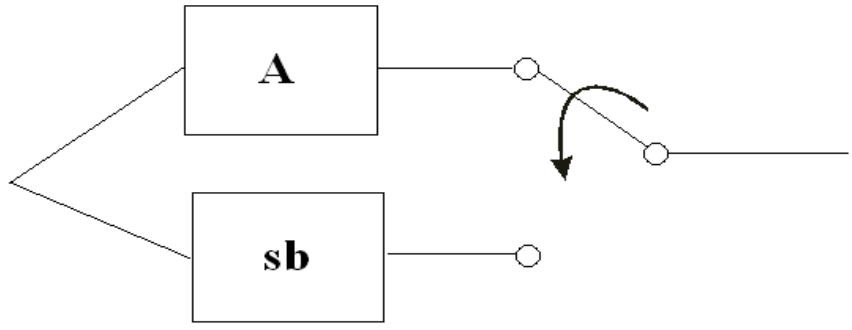
Figure 1. Standby component system with an auto-switching device.